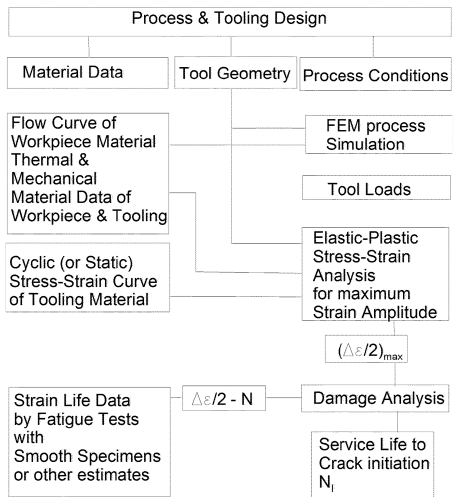
Figure 4. A suggested flow chart for the assessment of fatigue life of tools after ref. [1].